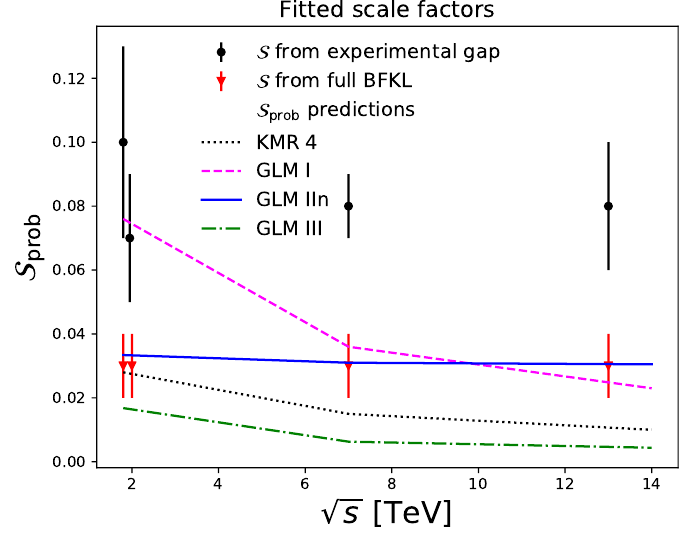
√ s with the CP1 tune